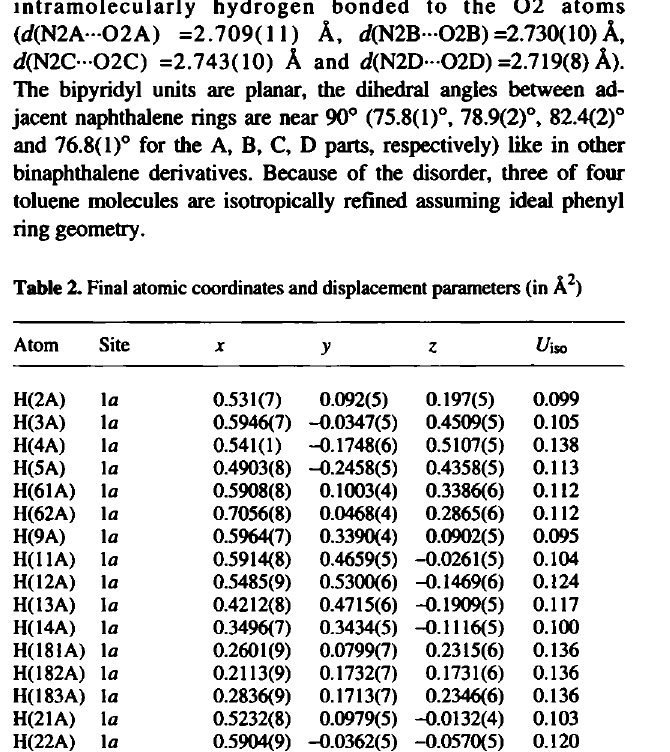
Table 1. Parameters used for the X-ray data collection Crystal: